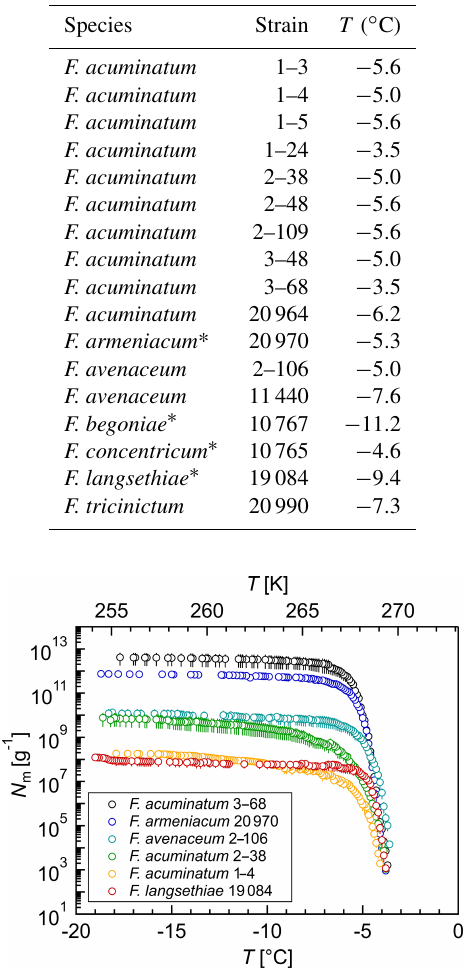
Table 1. Ice-nucleation-active Fusarium strains with correspond- ing mean freezing temperatures of the initial screening. The newly identified IN-active Fusarium species are marked with an asterisk ( ∗ ).